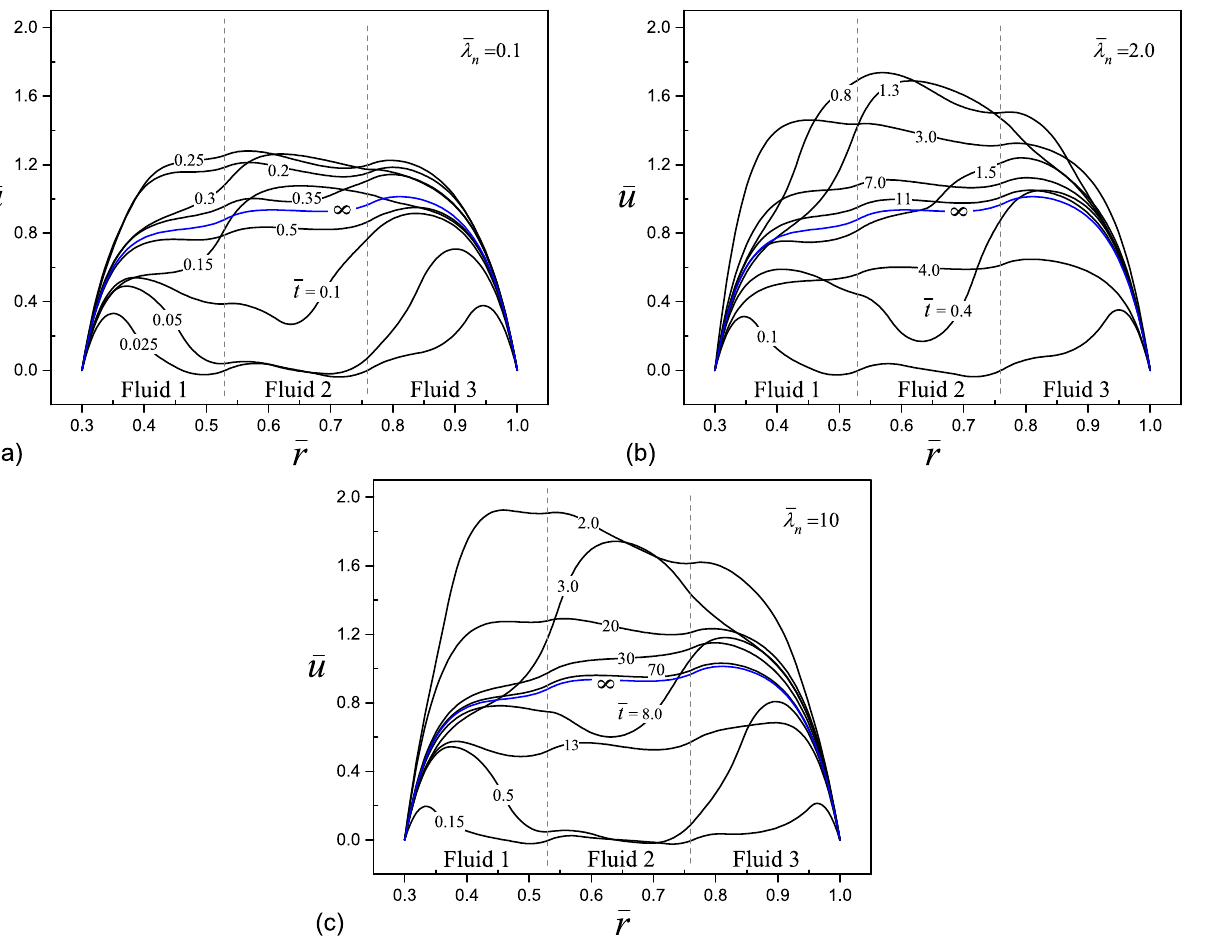
Figure 4. Dimensionless velocity profiles of a purely electro-osmotic flow with n = 3, a = 0.3, Γ = 0, ¯ κ n = 20, ∆ ¯ ψ n = 0.25, ¯ ρ n = ¯ η n = ¯ (cid:101) n = ¯ ζ I,O = 1, ¯ r 1 = 0.533 and ¯ r 2 = 0.766, for ( a ) ¯ λ n = 0.1, ( b ) ¯ λ n = 2.0, and ( c ) ¯ λ n =